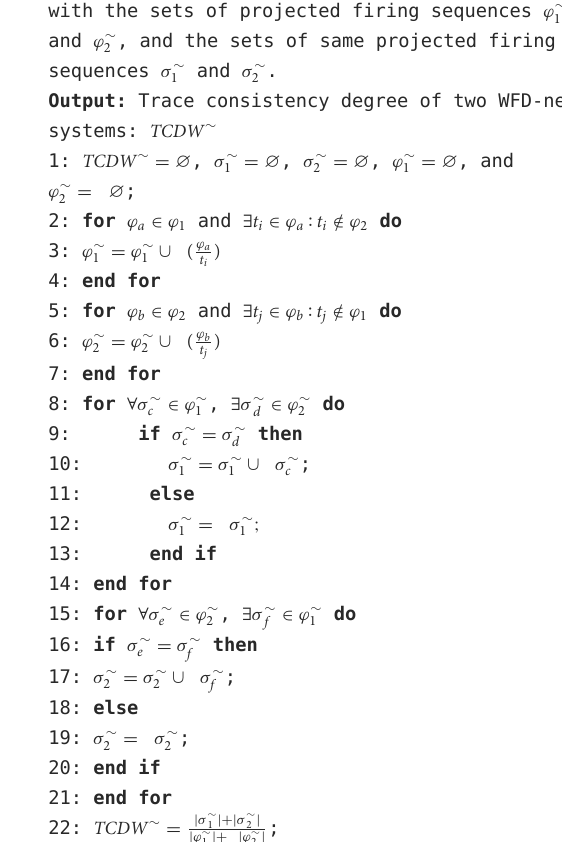
Algorithm 1. Trace consistency degree of two WFD-net systems.